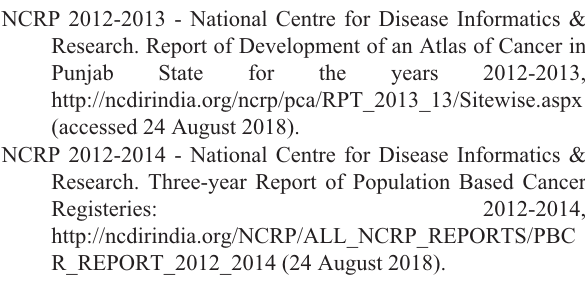
Figure S1 – Agarose gel picture for BRCA1 c.190T>C (p.Cys64Arg). Figure S2 – Agarose gel picture for BRCA1 1307delT. Figure S3 – Agarose gel picture for BRCA1 c.5331G>A (p.G1738R). Figure S4 – Agarose gel picture for BRCA1 c.2612 C>T